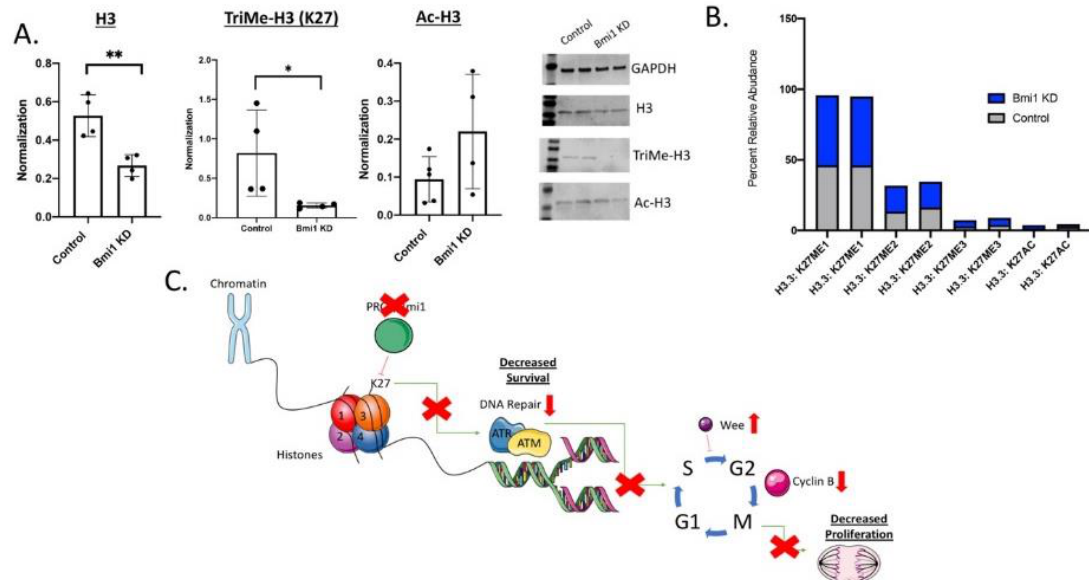
Figure 5. Bmi1 knockdown inhibits differentiation and modifies the epigenetic regulation in CBSCs: ( A ) Western blot analysis of histone 3 ( p value 0.006), trimethylated histone 3 ( p value 0.050), and acetylated histone 3 in CBSCs with and without Bmi1 using GAPDH for control ( n = 4); ( B ) ModSpec data of Bmi1 KD versus control CBSCs for the percent of histone modification on H3K27 ( n = 3); and ( C ) schematic representation of the mechanism describing the loss of Bmi1 in CBSCs. * p < 0.05, ** p < 0.01.